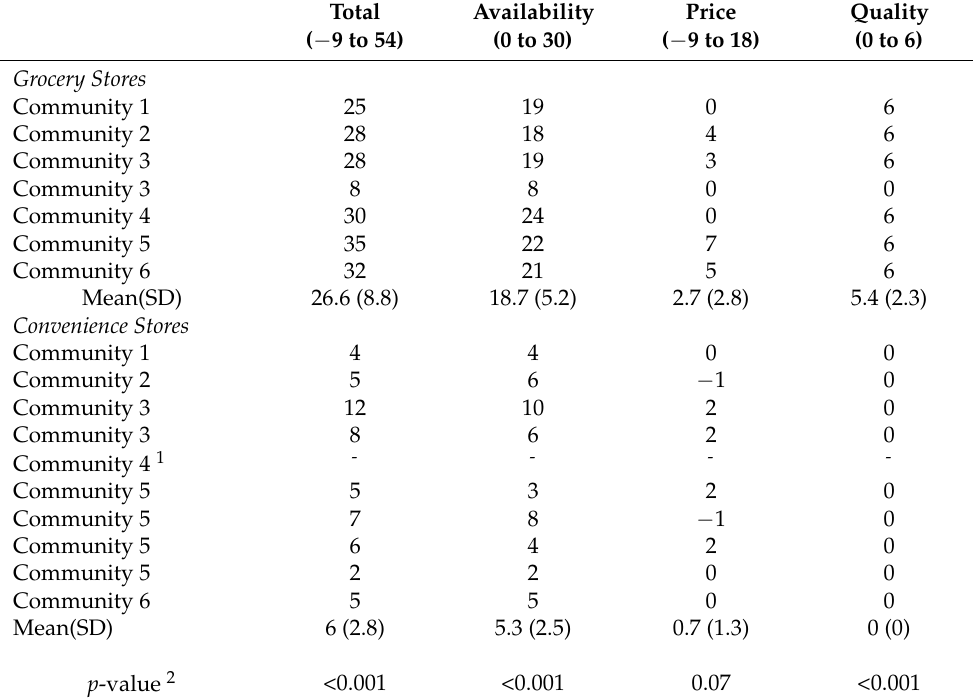
Table 1. Overall NEMS-S scores and sub-scores for grocery and convenience stores by community.